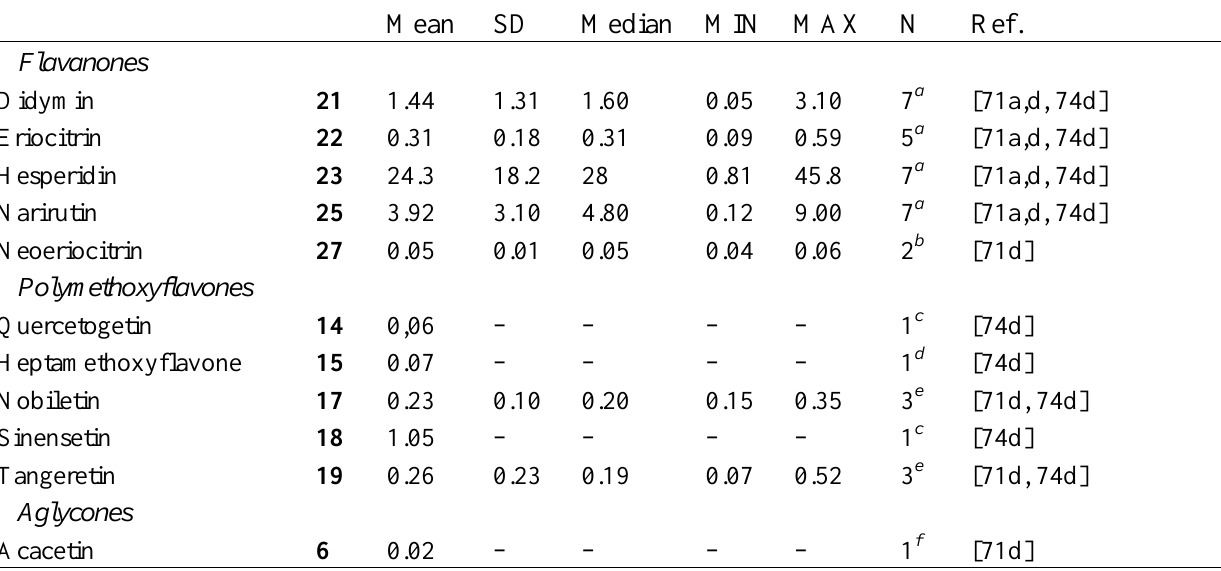
Table 8 . Flavonoid composition of C. reticulata juice (mg/100 mL).